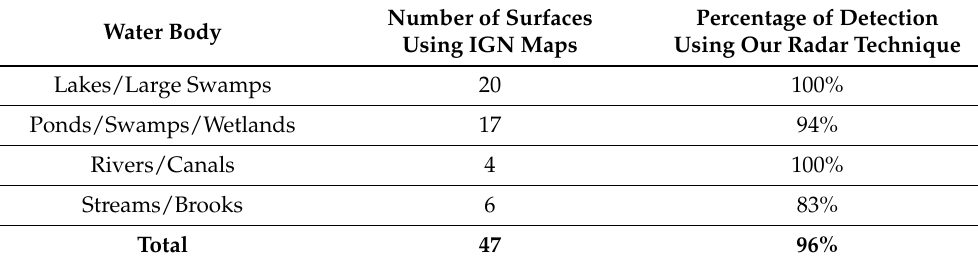
Table 2. Performance assessment of the proposed radar technique for water body surface detection. Results of the manual inspection applied between the IGN images and our radar technique per water body type and in total (bold) for the study